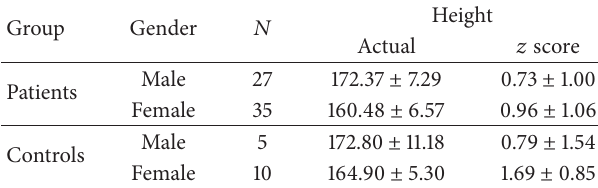
Table 3: Height and height 𝑧